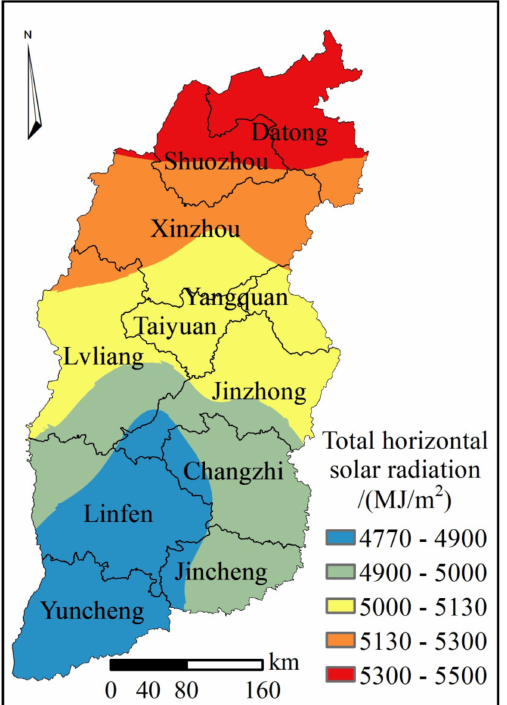
Figure 3. Spatial distribution of annual total horizontal solar radiation in Shanxi province. The annual total horizontal solar radiation in Shanxi province gradually decreases from north to south, with significant difference between north and south, and the total horizontal solar radiation in the central basin area is smaller than that in the two sides of the same latitude, as shown in Figure 3. The high value region appeared in the northern part of Shanxi province, including Datong city and Shuozhou city, as well as the northeastern and northwestern parts of Xinzhou city. The lowest values are concentrated in the southwest of Shanxi province, especially in the Linfen Basin and the Yuncheng Basin. According to the regional statistics of the total horizontal solar radiation in Shanxi province, the annual average horizontal solar radiation of Shanxi province is 5090.89 MJ/m 2 . Datong city has the largest annual total horizontal solar radiation, reaching 5456.1 MJ/m 2 . Yuncheng city has the smallest annual total horizontal solar radiation with an average annual horizontal solar radiation of only 4769.6 MJ/m 2